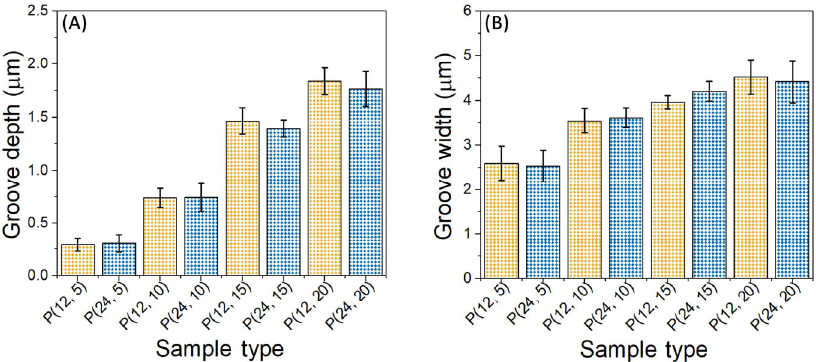
Fig. 4 Measured groove depth and width of Hilbert curve textures fabricated with different laser powers and texture path segment length: (A) depth and (B) width.